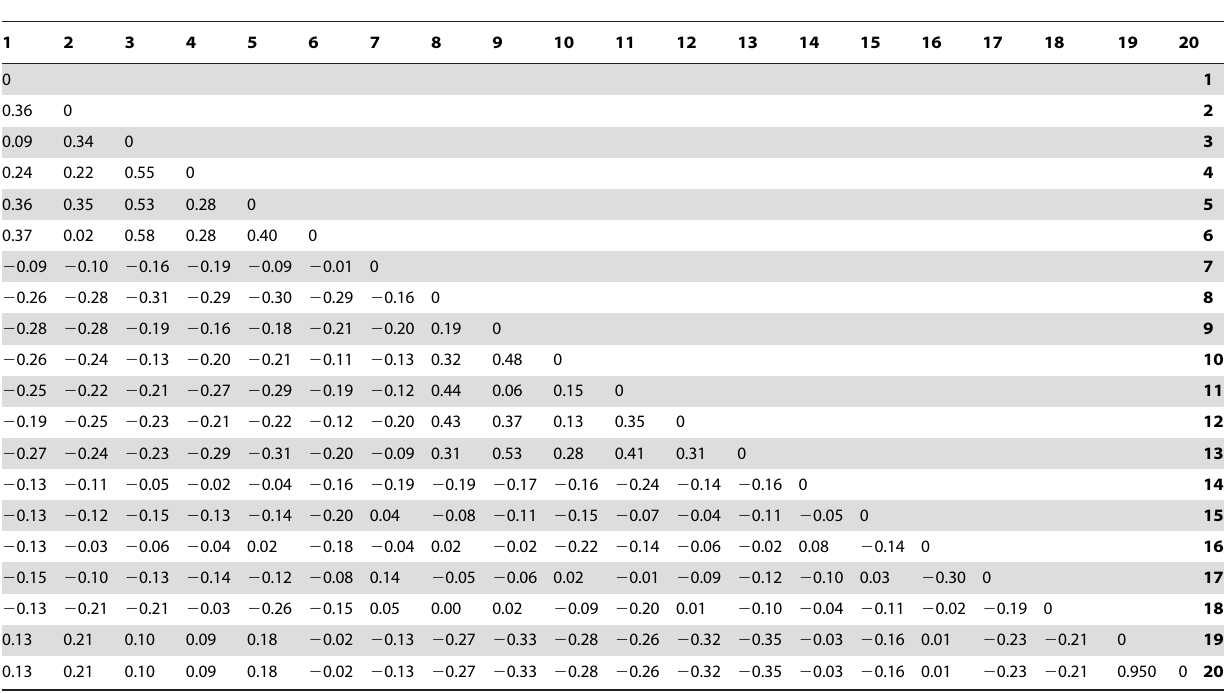
Table 4. Labelled pair wise relatedness matrix